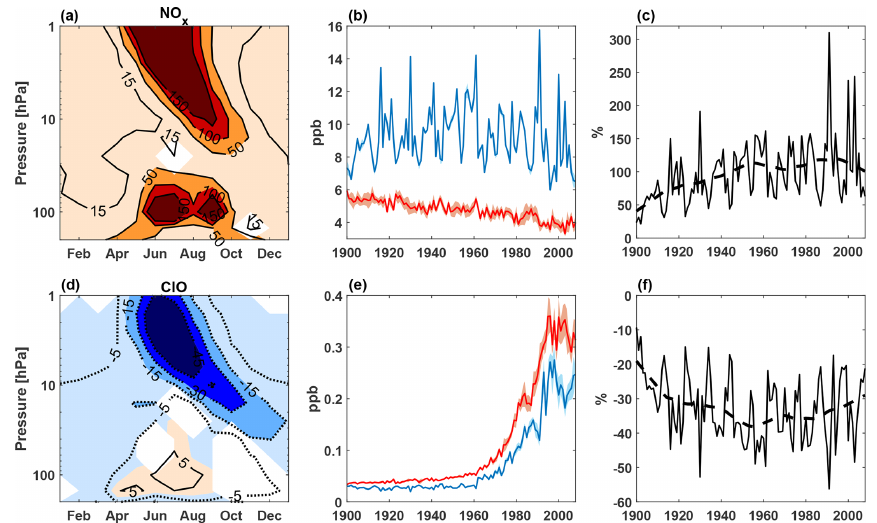
Figure 7. (a) Relative difference (EXP − REF) / REF in the monthly zonal mean polar NO x (70–90 ◦ S, 1–200hPa) during 1979–2008. Positive contour levels are 15%, 50%, 100% and 150%. Colour shading indicates areas significant at the 95% level calculated with a Monte Carlo simulation and a false detection rate. (b) September–October ensemble mean time series of polar NO x (70–90 ◦ S, 10–20hPa) in EXP (blue) and REF (red). Shaded light blue and red areas represent 95% confidence intervals of ensemble means. (c) Relative difference of EXP and REF (solid line) and 31-year smooth trend (dotted line). (d) Polar ClO with negative contour levels of − 5%, − 15%, − 30%, −